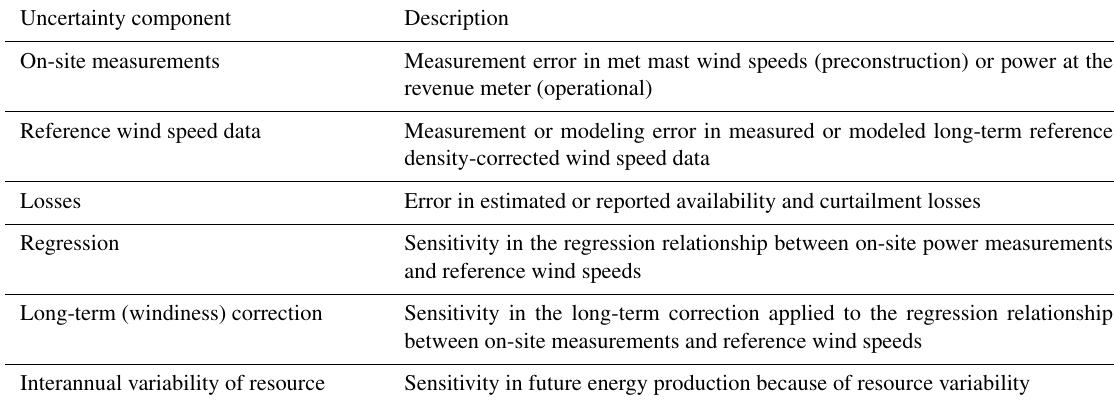
Table 1. Main sources of uncertainty in an AEP